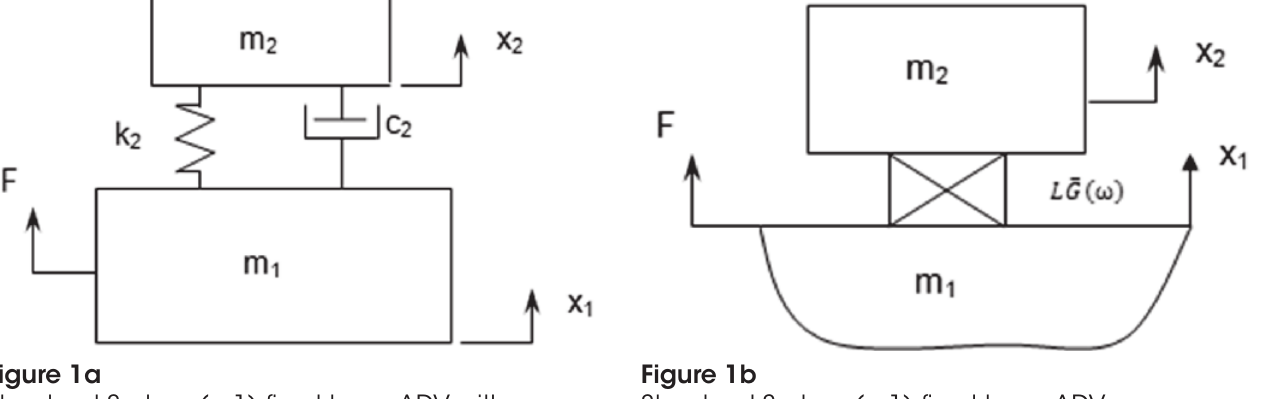
Structural System (m1) fixed to an ADV with viscous damping